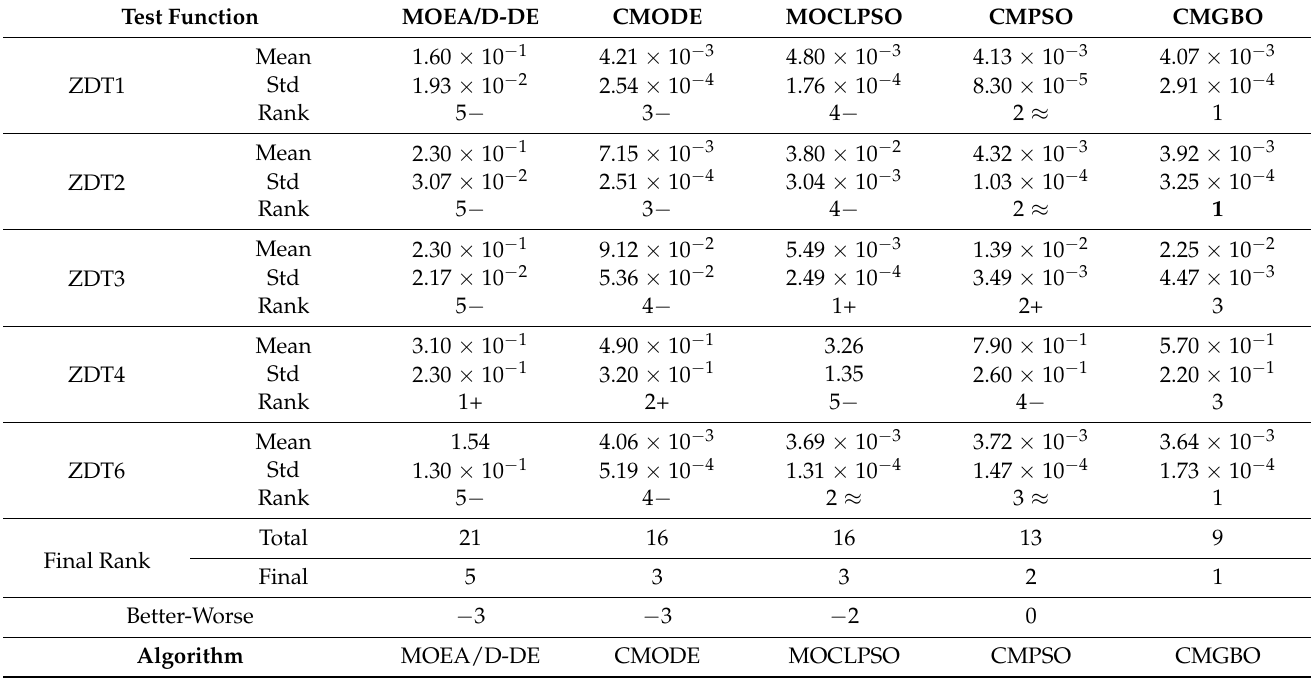
Table 3. Consequences on the ZDT